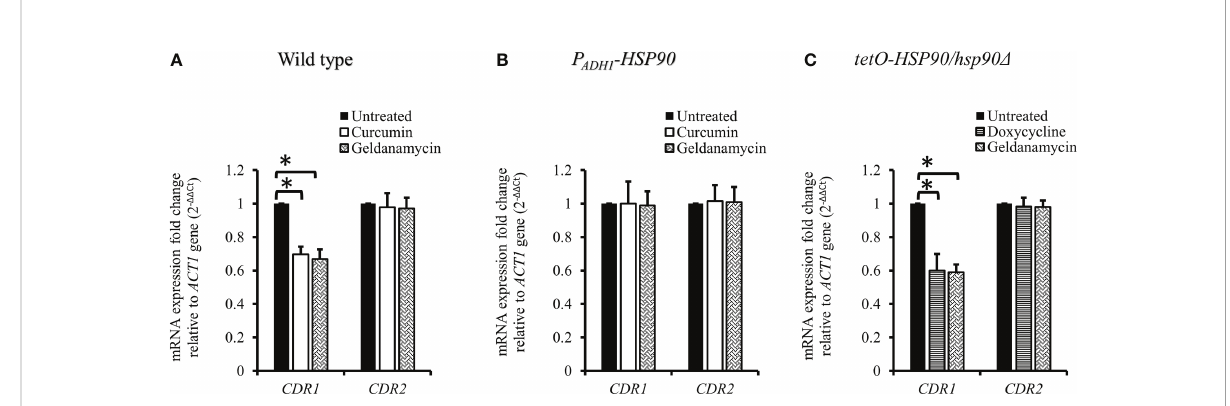
FIGURE 6 Transcriptional levels of CDR1 and CDR2 in the presence of curcumin and geldanamycin. Effects of curcumin on CDR1 and CDR2 gene expression for wildtype (A) , P ADH1 -HSP90 (B) , and tetO-HSP90/hsp90 D strains (C) after treatment with curcumin or geldanamycin. Error bars represent standard deviation from the mean of duplicate measurements. * indicates a statistically signi fi cant difference (p<0.05) compared to the respective control group.